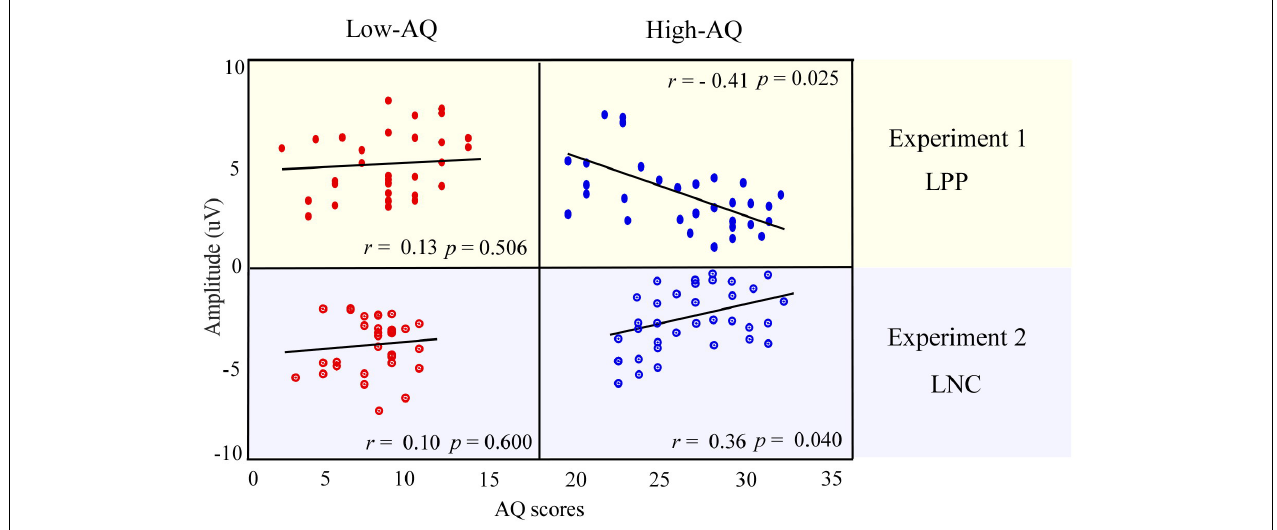
FIGURE 4 | Event-related potential waveforms, scalp topography distributions, and bar charts for Experiment 1. ERP waveforms exhibited by the High-AQ (blue) and Low-AQ (red) groups in response to positively (left column) , neutral (middle column) , and negatively (right column) valenced pictures with social (solid) or non-social (dotted) dimensions. Electrodes used to estimate the ERP amplitudes were marked using the black squares on their respective topographic distributions. Data in the bar charts were expressed as Mean ± SEM. ns p > 0.05, * p < 0.05, ** p < 0.01, *** p <